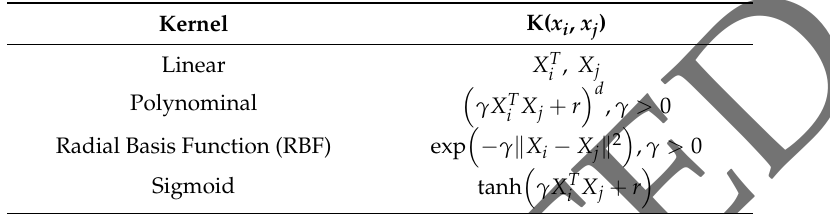
Table 2. SVM Kernel